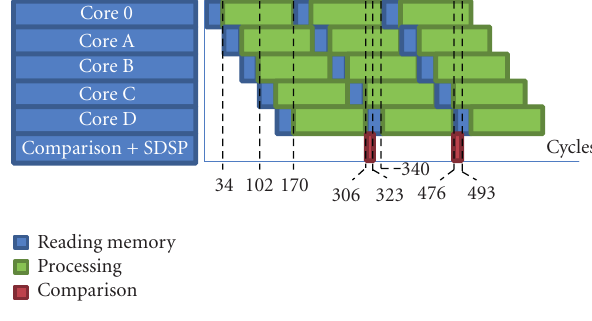
Figure 11: Clock cycles